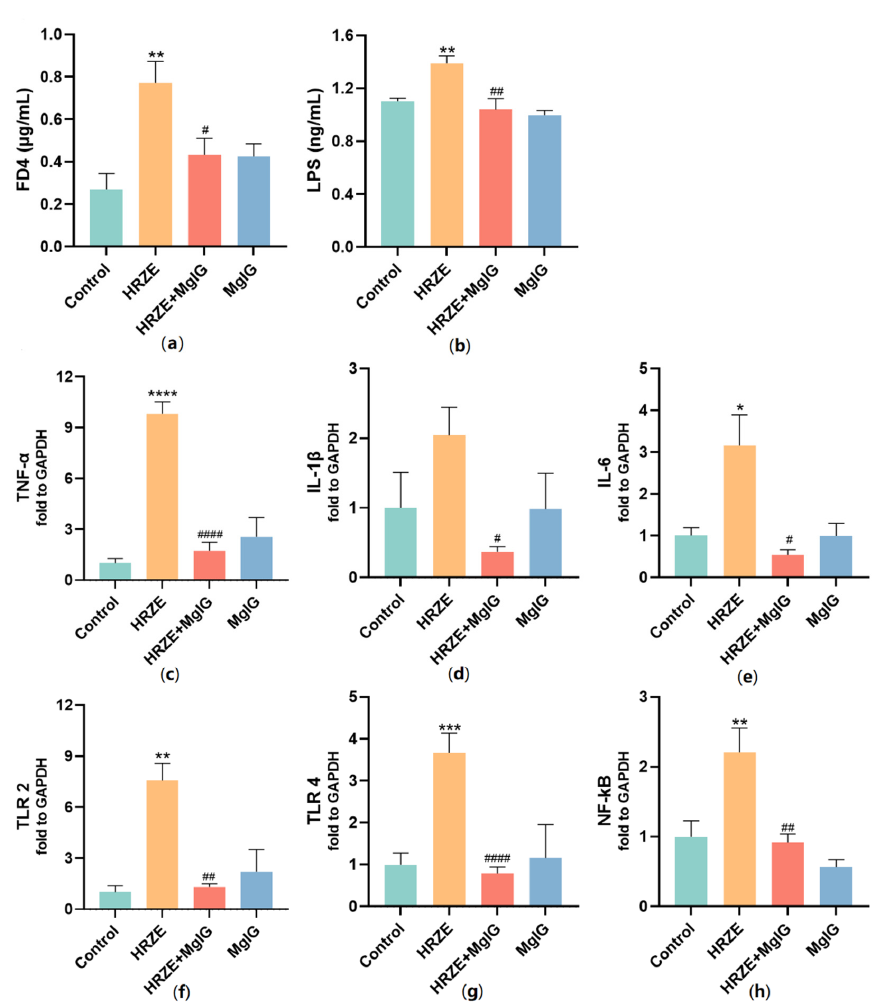
Figure 5. MgIG decreases intestinal permeability and inhibits LPS/TLRs/NF- κ B pathway activation induced by HRZE. ( a ) Serum concentration of FD4 ( n = 5 per group); ( b ) serum concentration of LPS ( n = 6 per group); ( c ) TNF- α , ( d ) IL-1 β , ( e ) IL-6, ( f ) TLR2, ( g ) TLR4, and ( h ) NF- κ B mRNA levels of liver tissue in each group ( n = 6 per group). The data are presented as the means ± SEM ( n = 6